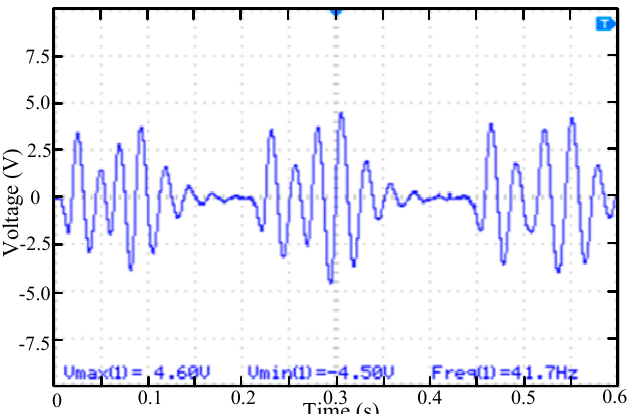
Figure 8. The voltage waveform of the piezoelectric beam while rotating mass block rotates with three permanent magnets (positions 1, 3, 4).